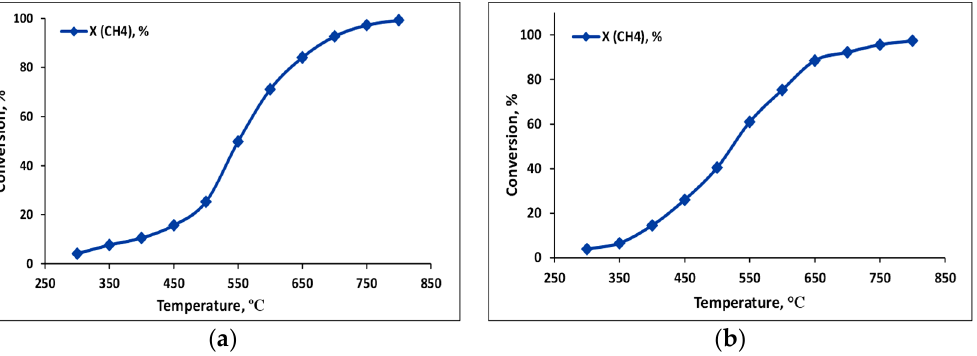
Figure 8. Effect of temperature on CH 4 conversion in SRM over 5%Co-Rh/Al 2 O 3 at СН 4 :H 2 O = 1:1, P = 1 atm, GHSV = 1000 h −1 : ( a ) Co:Rh = 95:5, ( b ) Co:Rh =